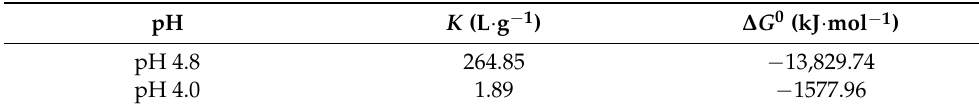
Table 2. Gibbs free energy ( ∆ G 0 ) for adsorption processes under two pHs.